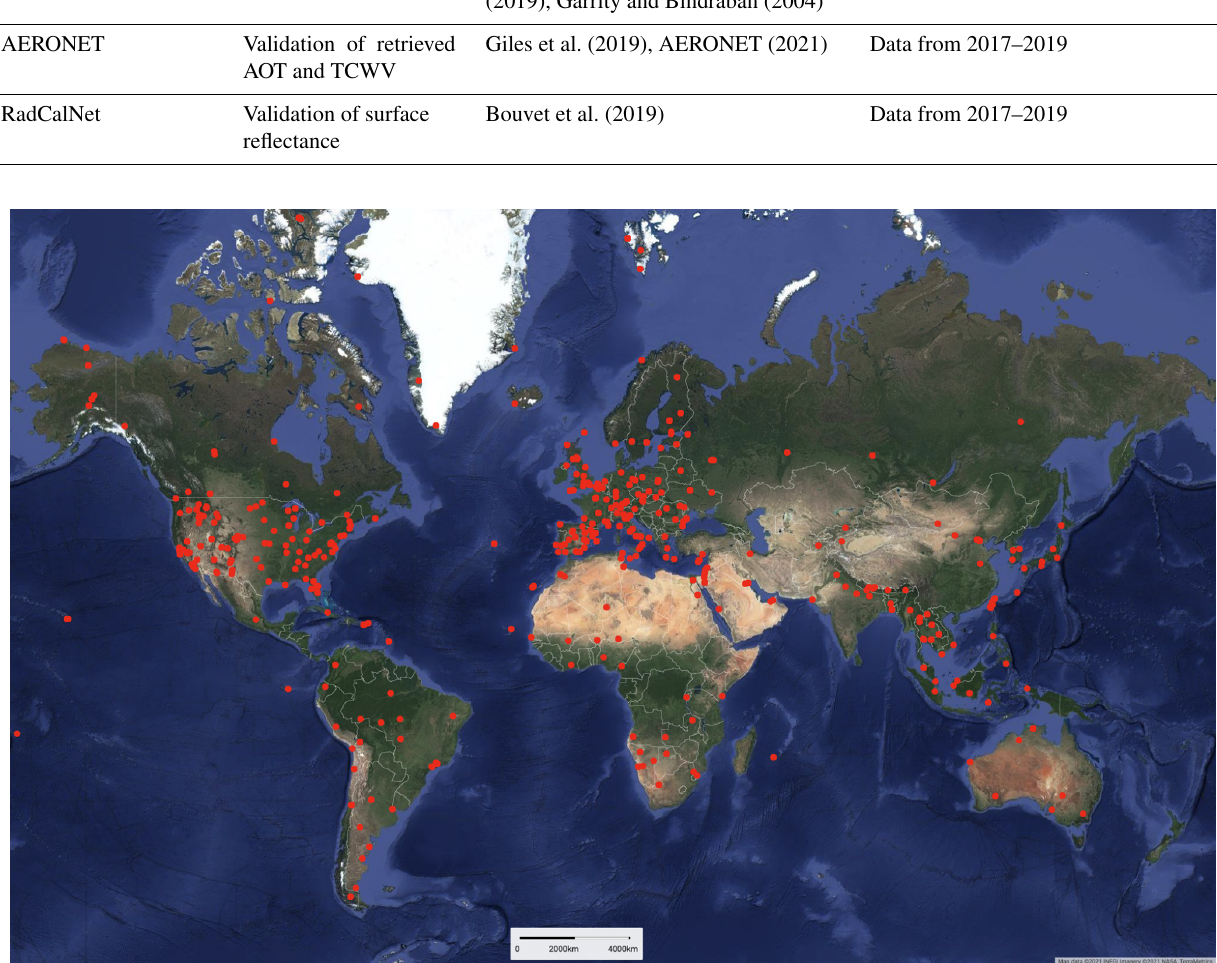
Figure 3. Globally distributed AERONET sites (dot markers) used in this study for the validation of retrieved atmospheric parameters.